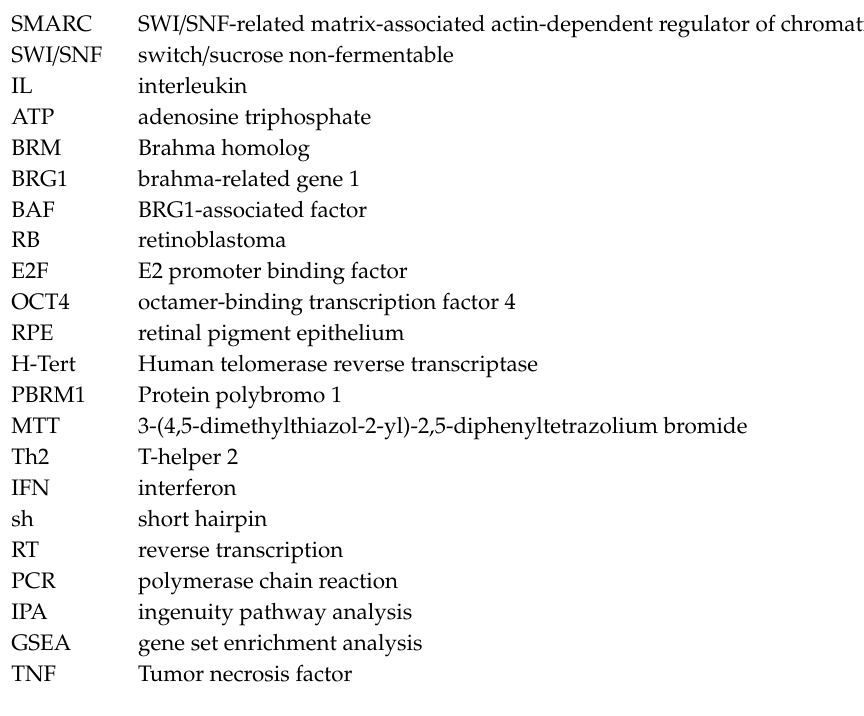
Figure S1. SMARCB1 binds to regulatory region of IL6 upstream regulators without transcription level